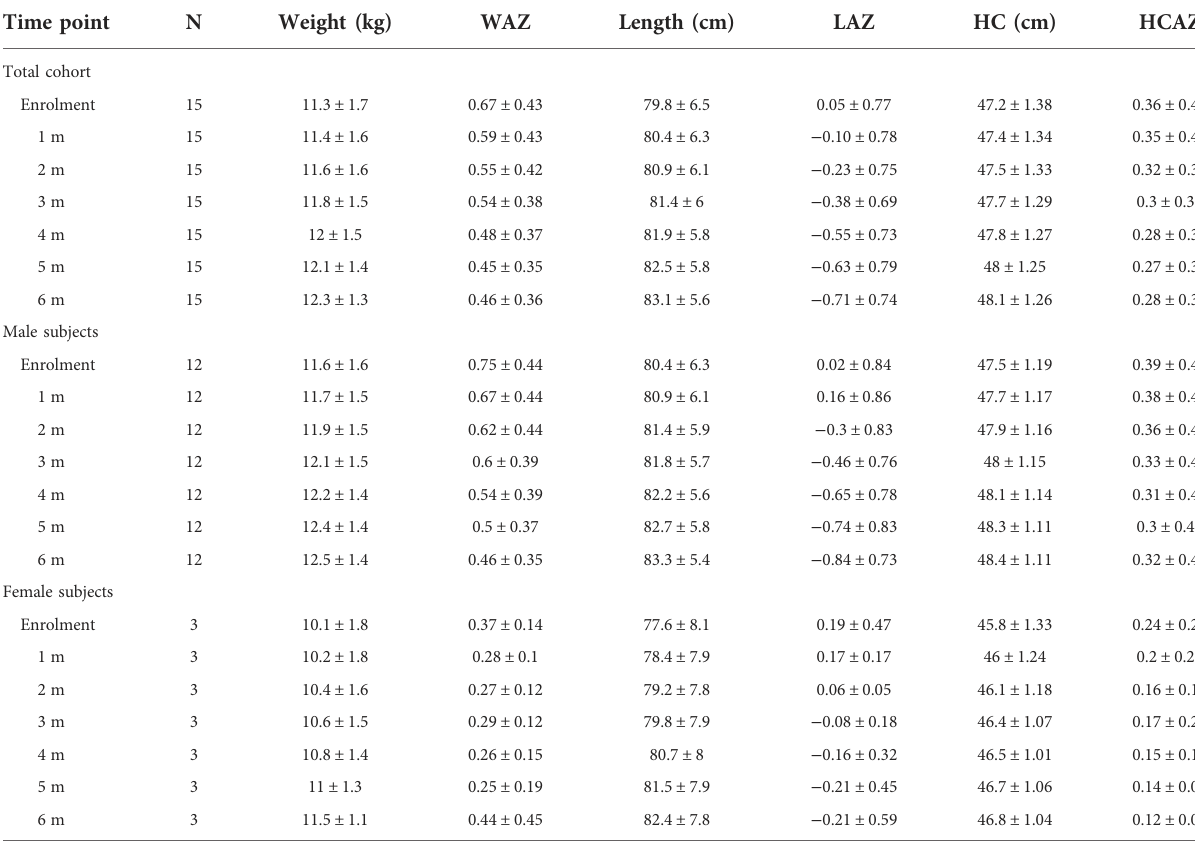
TABLE 2B Anthropometric measurements of healthy controls. Time